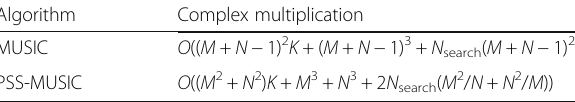
Table 2 Computational complexity of different methods Algorithm Complex multiplication